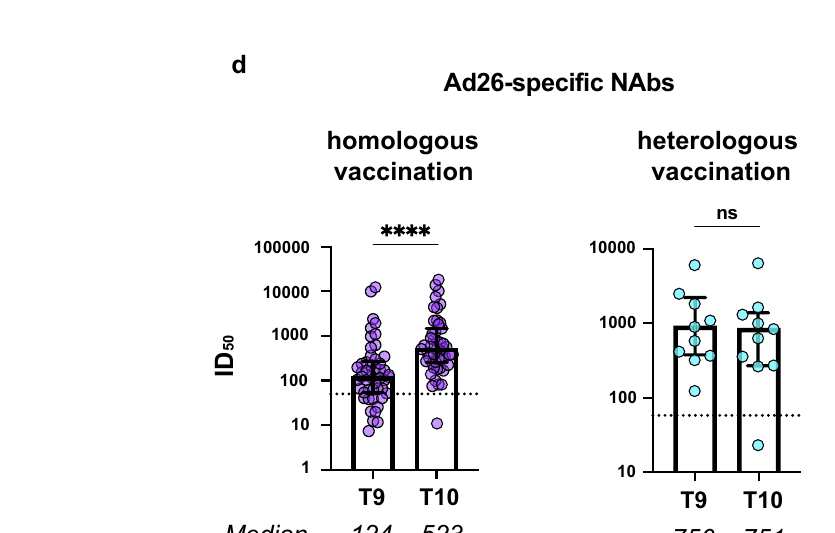
Fig. 1 Booster vaccination with rAd26-vectored Gam-COVID-Vac elicits high titers of serum Ad26-speci fi c NAbs. a Timeline showing Gam- COVID-Vac vaccination and blood sampling timepoints, labeled according to the number of months elapsed after the fi rst dose. b Outline of the rAd26 virus neutralization assay. In a subpanel, representative fl ow plots show Spike expression on the surface of A549 cells after rAd26- Spike infection in the absence of Ad26-neutralizing antibodies (left) and in the presence of a saturating amount of Ad26 Nab (right). Any anti- Spike activity in serum samples was blocked by adding the excess of recombinant Spike protein (not shown). c Representative rAd26 neutralization curves for serum samples before (T9) and one month after (T10) the Gam-COVID-Vac boost. Ad26 neutralizing activity was de fi ned by the percentages of Spike + A549 cells relative to no antibody controls. d Serum Ad26 virus-neutralizing antibody titers before and one month after booster vaccination in homologous (Gam-COVID-Vac/Gam-COVID-Vac) and heterologous (Gam-COVID-Vac/P fi zer-BioNTech ’ s Comirnaty) vaccination groups. Dotted lines indicate the pre-prime baseline. Medians are plotted and statistical signi fi cance was determined using Wilcoxon matched-pairs signed-rank test. Data are presented as median values and interquartile ranges (IQR). **** P <